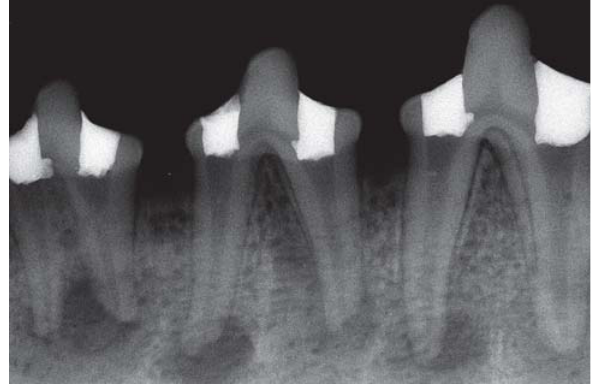
FIGURE 1- Experimentally induced periapical lesion